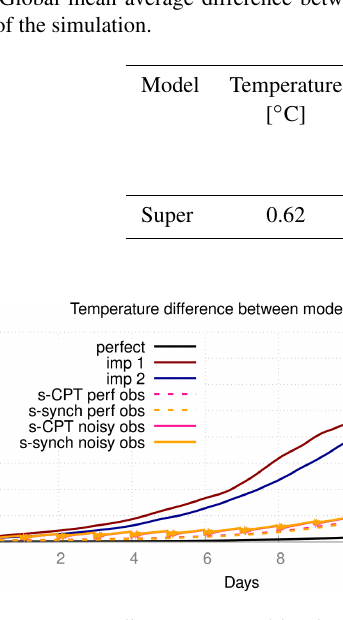
Figure 4. Forecast quality as measured by the RMSE of the truth and a model with a perturbed initial condition. The control is the difference between the perfect model and the perfect model with a perturbed initial condition. The pink and orange lines show the su- permodels trained by perfect observations (s-CPT/synch perf obs), and the supermodels trained by observations available every 24h (s-CPT/synch noisy obs),respectively, with the highest noise level used in this